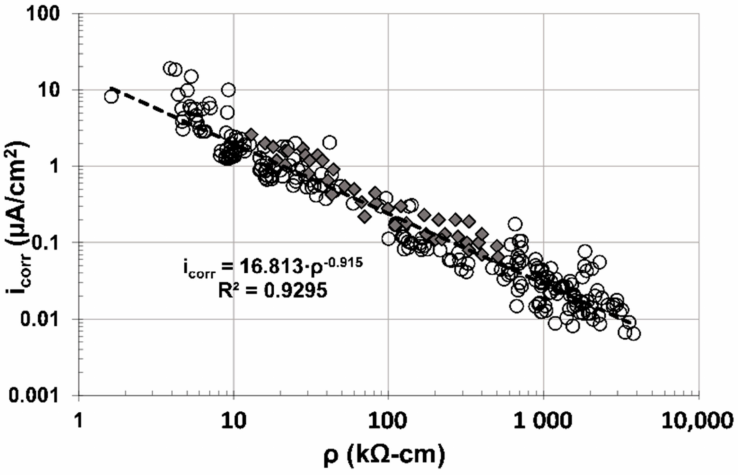
Figure 10. Composite plots of ρ and i corr for all mortar treatments evaluated ( previous investigations [16] using concrete specimens (